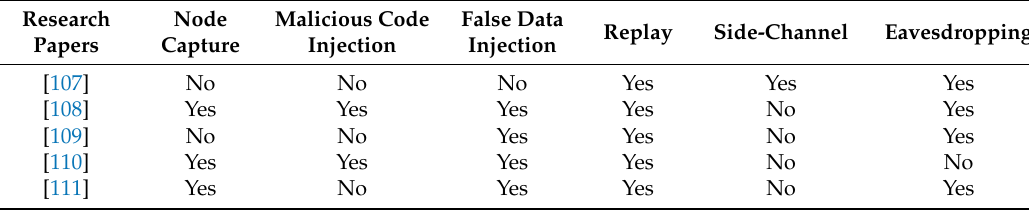
Table 11. Attacks on hybrid security and privacy